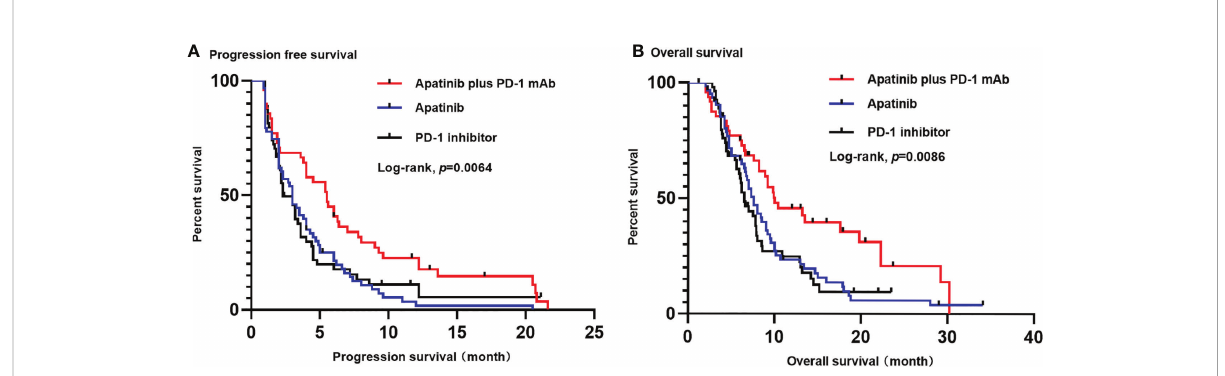
FIGURE 2 Kaplan-Meier estimates of PFS (A) and OS (B) for each group. (A) The median PFS was signi fi cantly longer in apatinib plus PD-1 mAb than in apatinib monotherapy (5.5 months versus 3.0 months; p=0.002) or in PD-1 mAb monotherapy (5.5 months versus 2.3 months; p=0.017). (B) The OS was signi fi cantly longer in apatinib plus PD-1 mAb than in apatinib monotherapy (10 months versus 7.6 months; p=0.011) or in PD-1 mAb group (10 months versus 6.5 months; p=0.004). PFS, progression-free survival. OS, progression-free survival; CI: con fi dence interval.